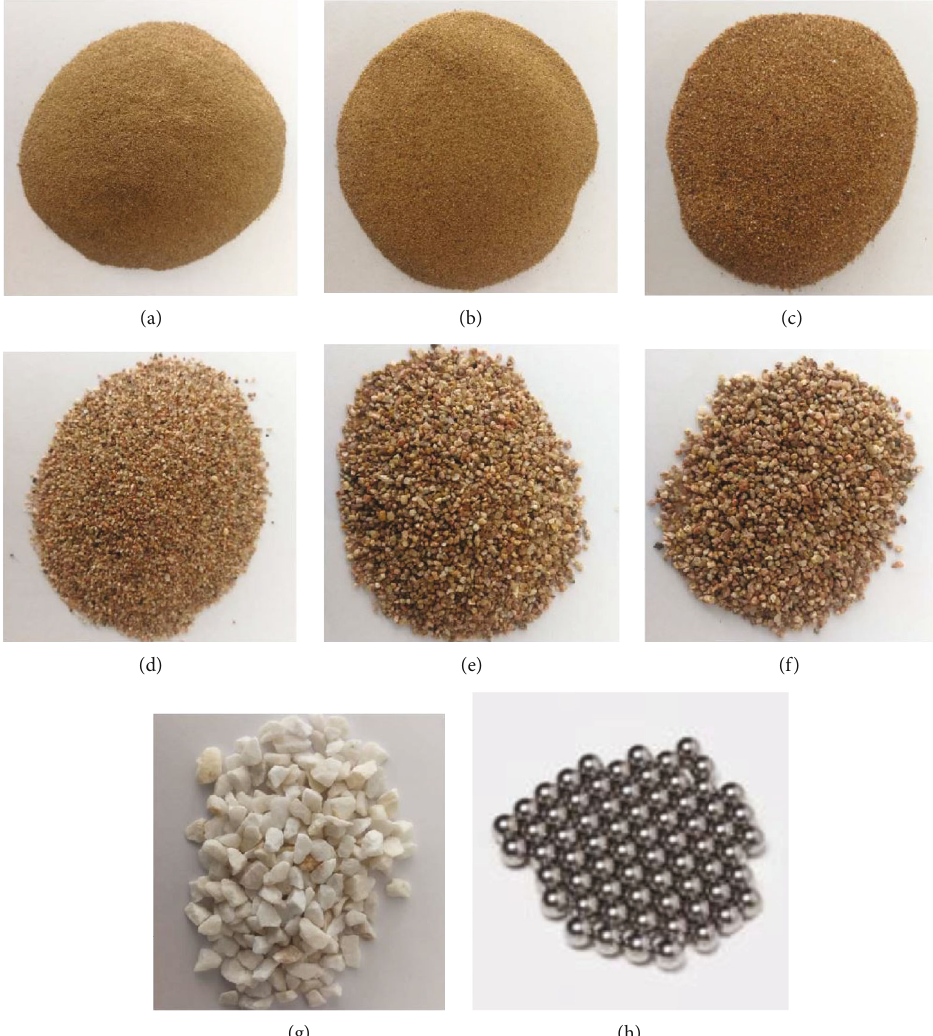
Figure 6: Experimental materials: Aeolian sand: (a) 0.075 – 0.15mm, (b) 0.15 – 0.3mm, and (c) 0.3 – 0.6mm; river sand: (d) 0.6 – 1.0mm, (e) 1.0 – 2.0mm, and (f) 2.0 – 2.36mm; quartz sand: (g) 4.75 – 9.5 mm; and steel balls: (h)